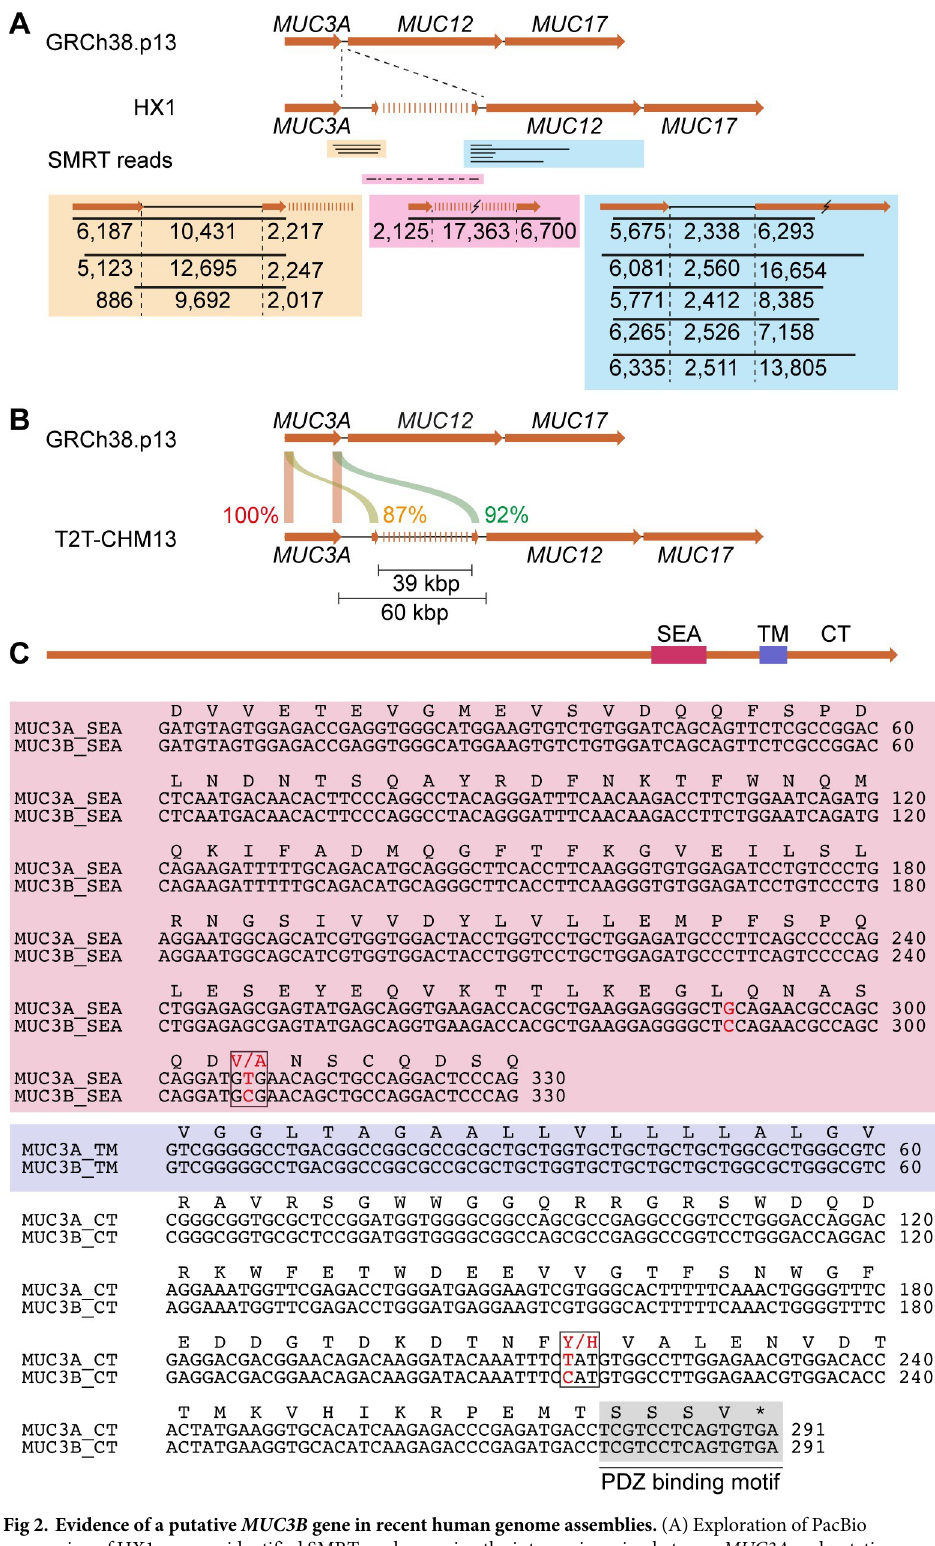
PLOS ONE | https://doi.org/10.1371/journal.pone.0275671 October 18,